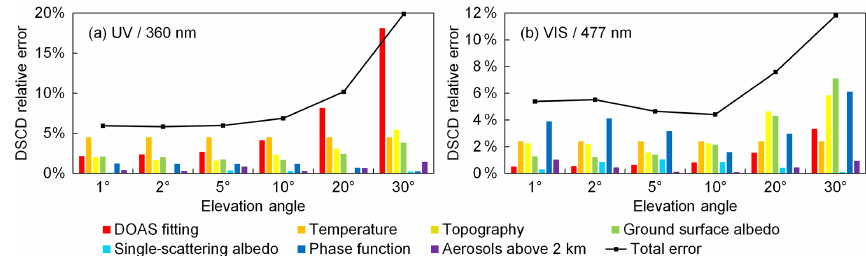
Figure 6. Same as Fig. 5, but for the scanning cycle on 7 December 2015 at ∼ 13:55UTC (SZA ∼ 79 ◦ , RAA ∼ 39 ◦